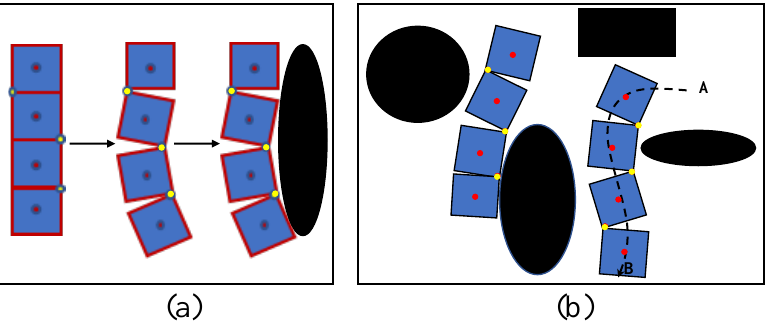
Figure 1. ( a ) A reconfigurable robot changes its shape according to the obstacle and navigates toward the obstacle for coverage. ( b ) Robot changes its shape to navigate through